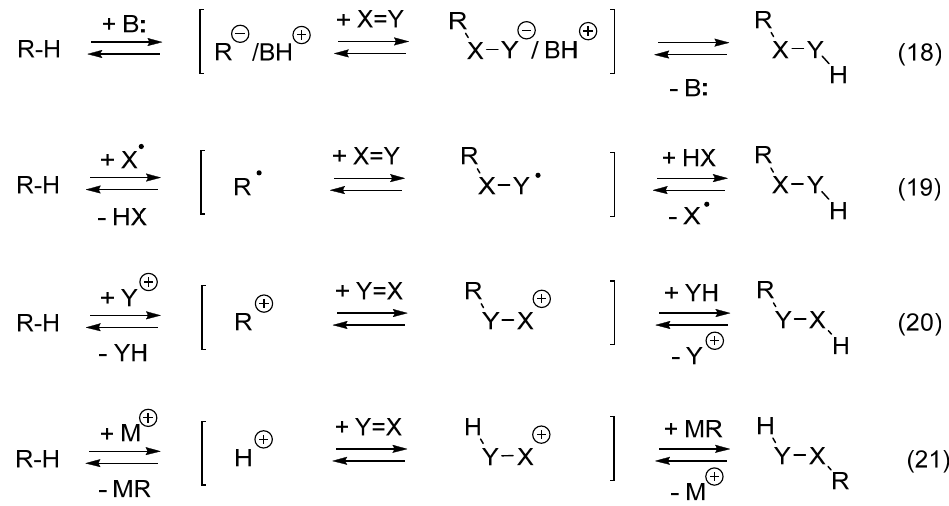
Figure 8. Classical general mechanisms for catalyzed hydrocarbations of unsaturated compounds. Polymerization of the unsaturated compound is a concurrent reaction.